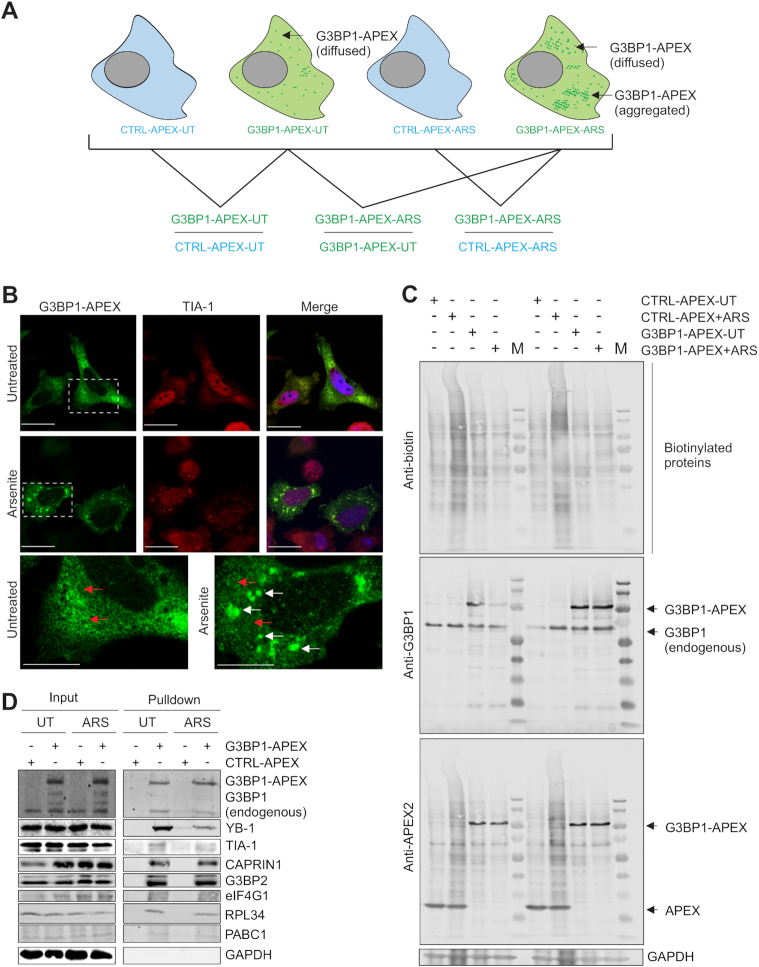
APEX method for the extraction of G3BP1-associated proteins and transcripts. (A) Schema for extracting and comparing G3BP1-associated proteins and transcripts. G3BP1-APEX, represented by green dots, is present as diffused in the vehicle treated cells while it is present as both aggregated as well as diffused in the arsenite treated cells. See Methods for details. (B) APEX-G3BP1 colocalization by immunofluorescence was assessed using the SG protein, TIA-1. A part of the image of APEX-G3BP1 immunostaining from vehicle treated and arsenite treated cells is enlarged and shown at the bottom panels. Note that G3BP1 is mainly present as diffused in the vehicle treated cells (red arrows) while it is present as both aggregated (white arrows) and diffused (red arrows) in the arsenite treated cells. Scale, 10 um. (C) Western blot showing detection of biotinylated proteins (lanes 1–4 and lanes 6–9) as detected using anti-biotin antibodies (first upper panel), G3BP1-APEX fusion protein and G3BP1 (endogenous) as detected using anti-G3BP1 antibodies (second panel), G3BP1-APEX fusion protein and APEX alone as detected by anti-APX2 (APEX2) antibodies (third panel). GAPDH is used as the loading control. (D) Western blot analysis to detect proteins associated with APEX-G3BP1 complexes in unstressed and arsenite treated cells.